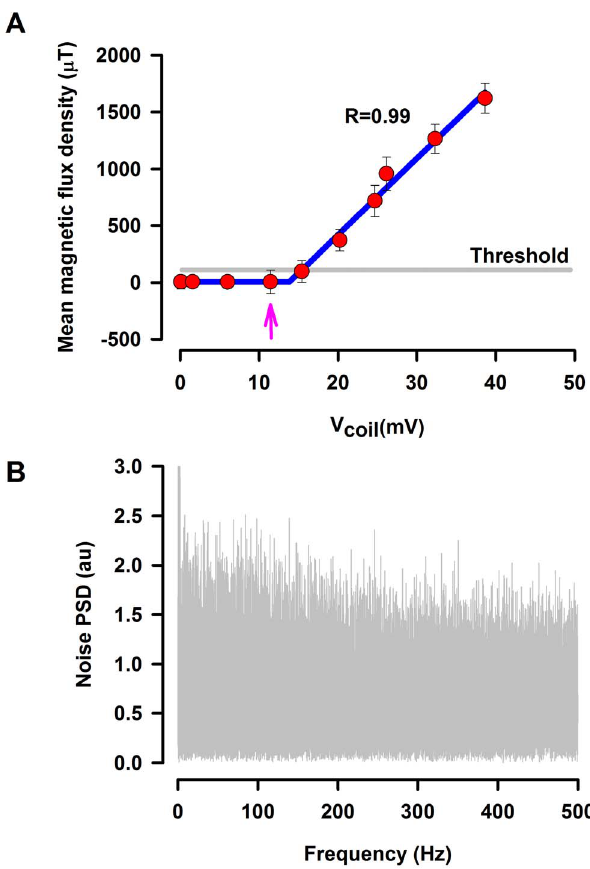
Figure 5. Graph employed to determine the threshold of our MEMS sensor and a graph illustrating the typical input noise. A , input-output curve to identify the threshold level of detection of our MEMS sensor. The horizontal axis indicates the input signal; i.e., the input voltage applied in the coil. The vertical axis shows the output signal; i.e., the magnetic flux density detected with the MEMS sensor. This type of input-output curve was useful to select the appropriated subthreshold signal (see vertical arrow) for every stochastic resonance experiment. B , the typical power spectra density (PSD) of magnetic noise (Gaussian noise from 0 to 500